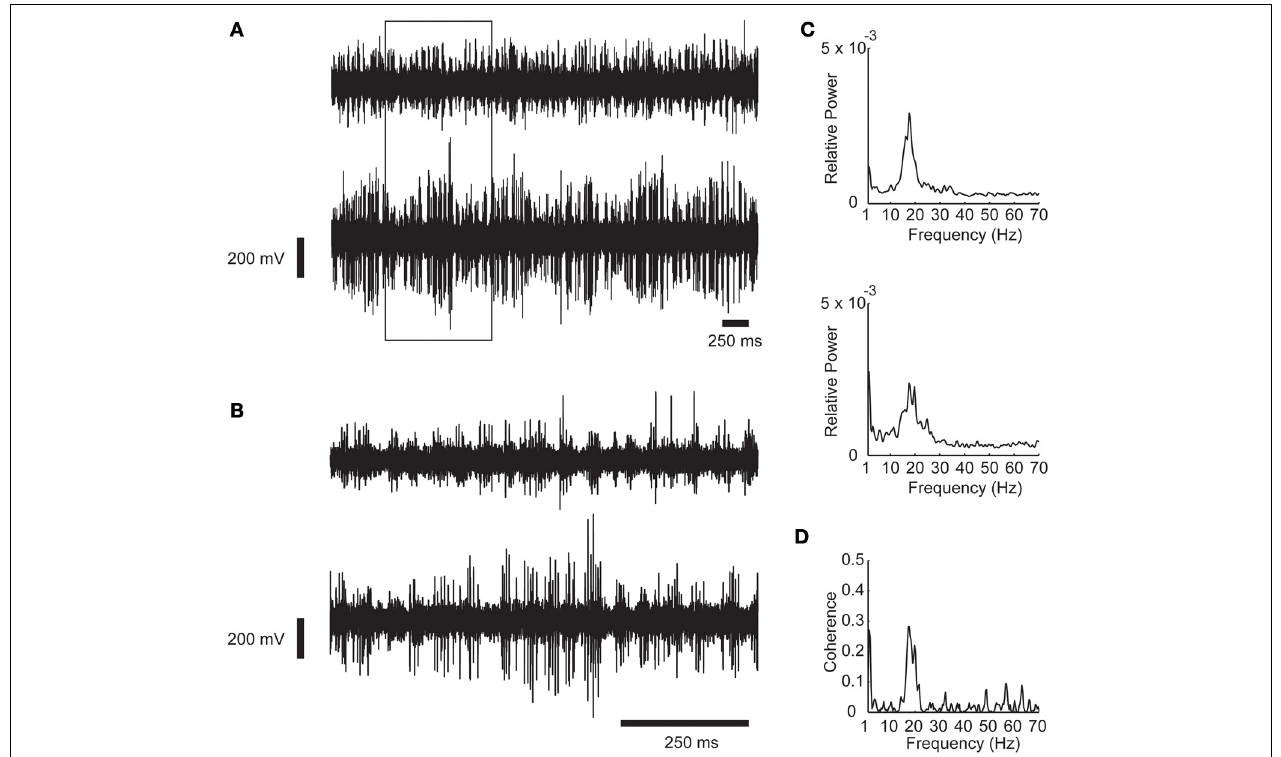
FIGURE 1 | An example of synchronous oscillations between two recording sites in the STN. (A) Raw analog data. Data is recorded by two microelectrodes separated horizontally by a distance of 2mm, hardware band pass filtered between 250 and 6000Hz, and digitally sampled at 48 KHz. The